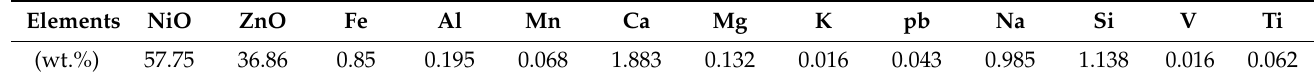
Table 5. Overall composition of the Ni/Zn product (wt.%).